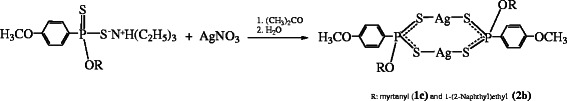
Synthesis of dinuclear silver(I) complexes (1c and 2c).